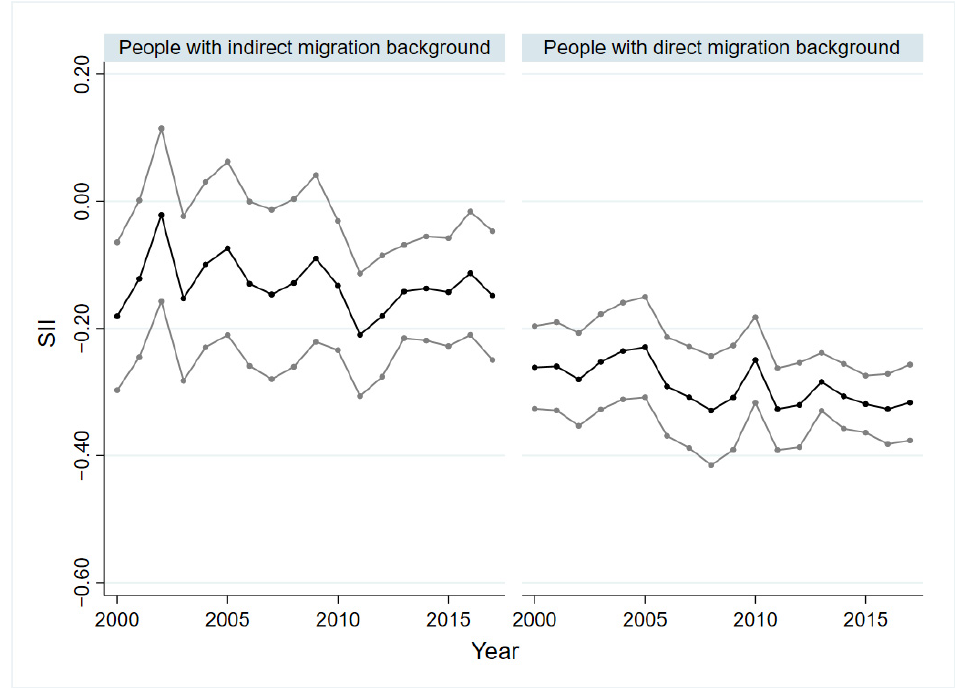
Figure 3. Absolute socio-economic inequalities in SRH in people with direct and indirect migration background, 2000–2017. SRH: self-rated health; SII: slope index of inequality; black line: regression coefficient; grey line: 95% confidence interval.